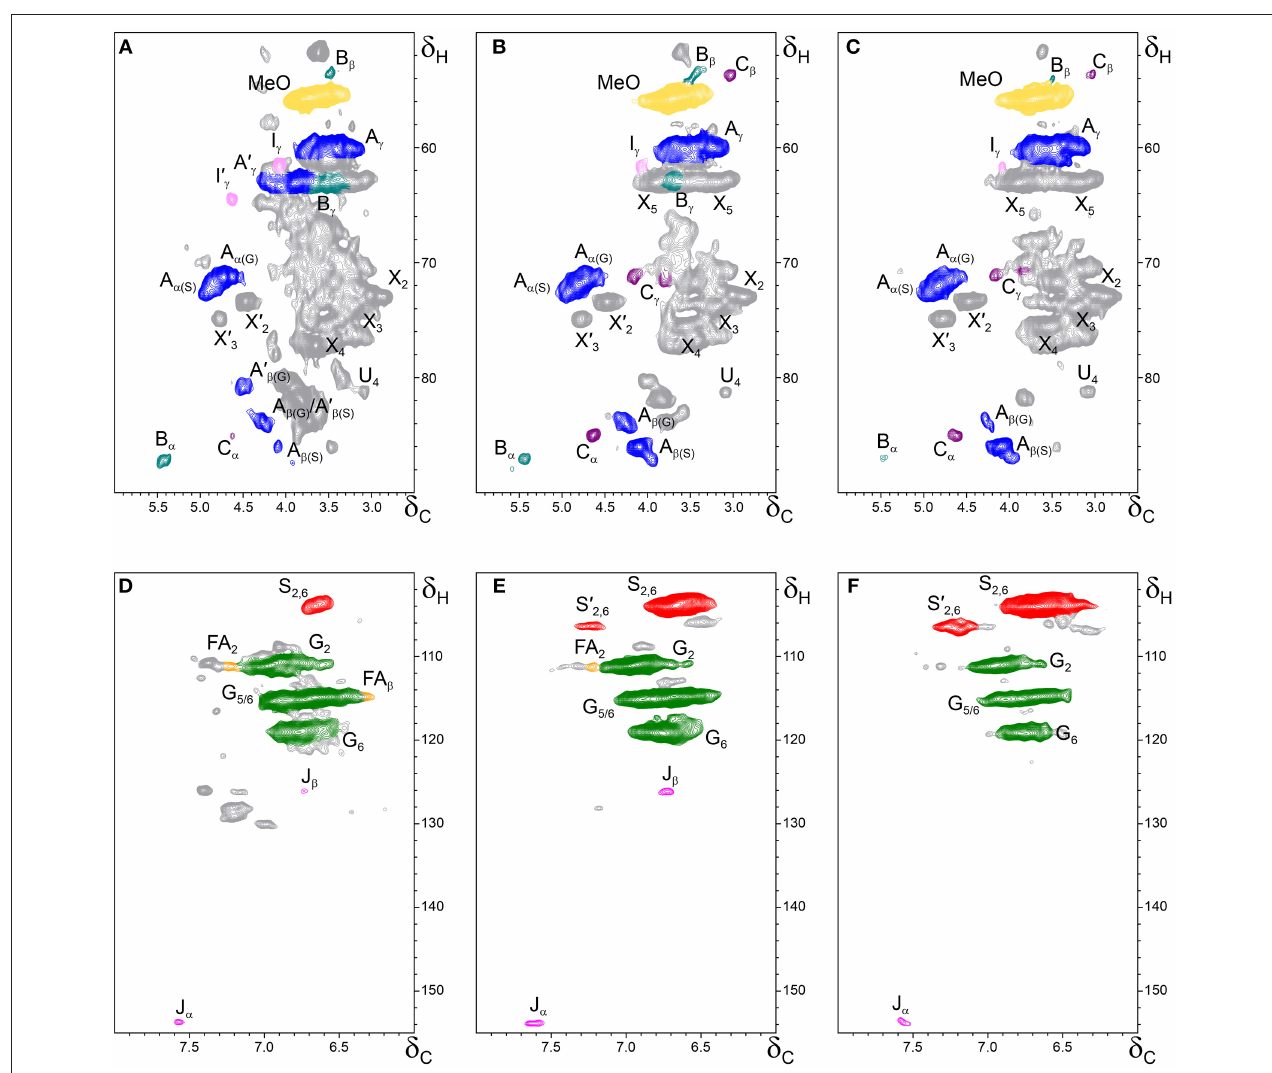
structures identified are depicted in Figure 5